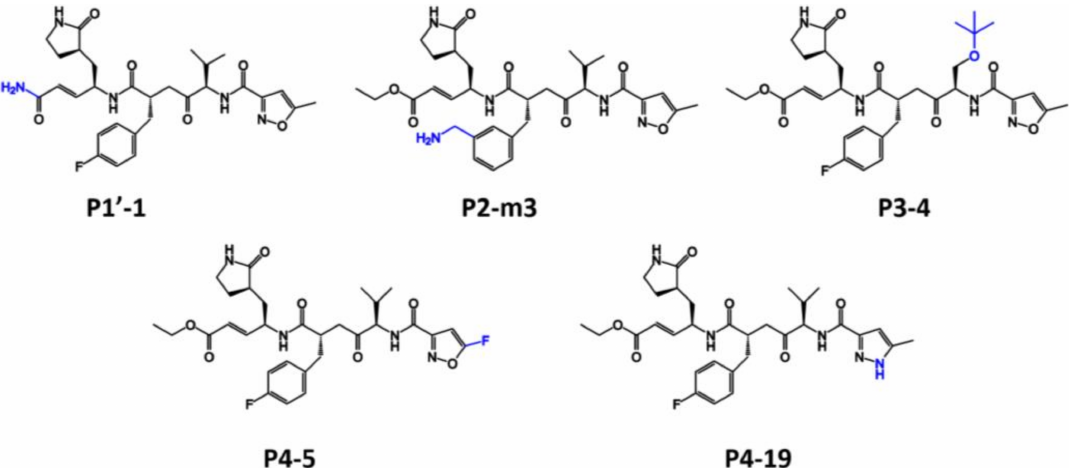
Figure 2. The chemical structure of five selected compounds with ∆∆ G bind < 0